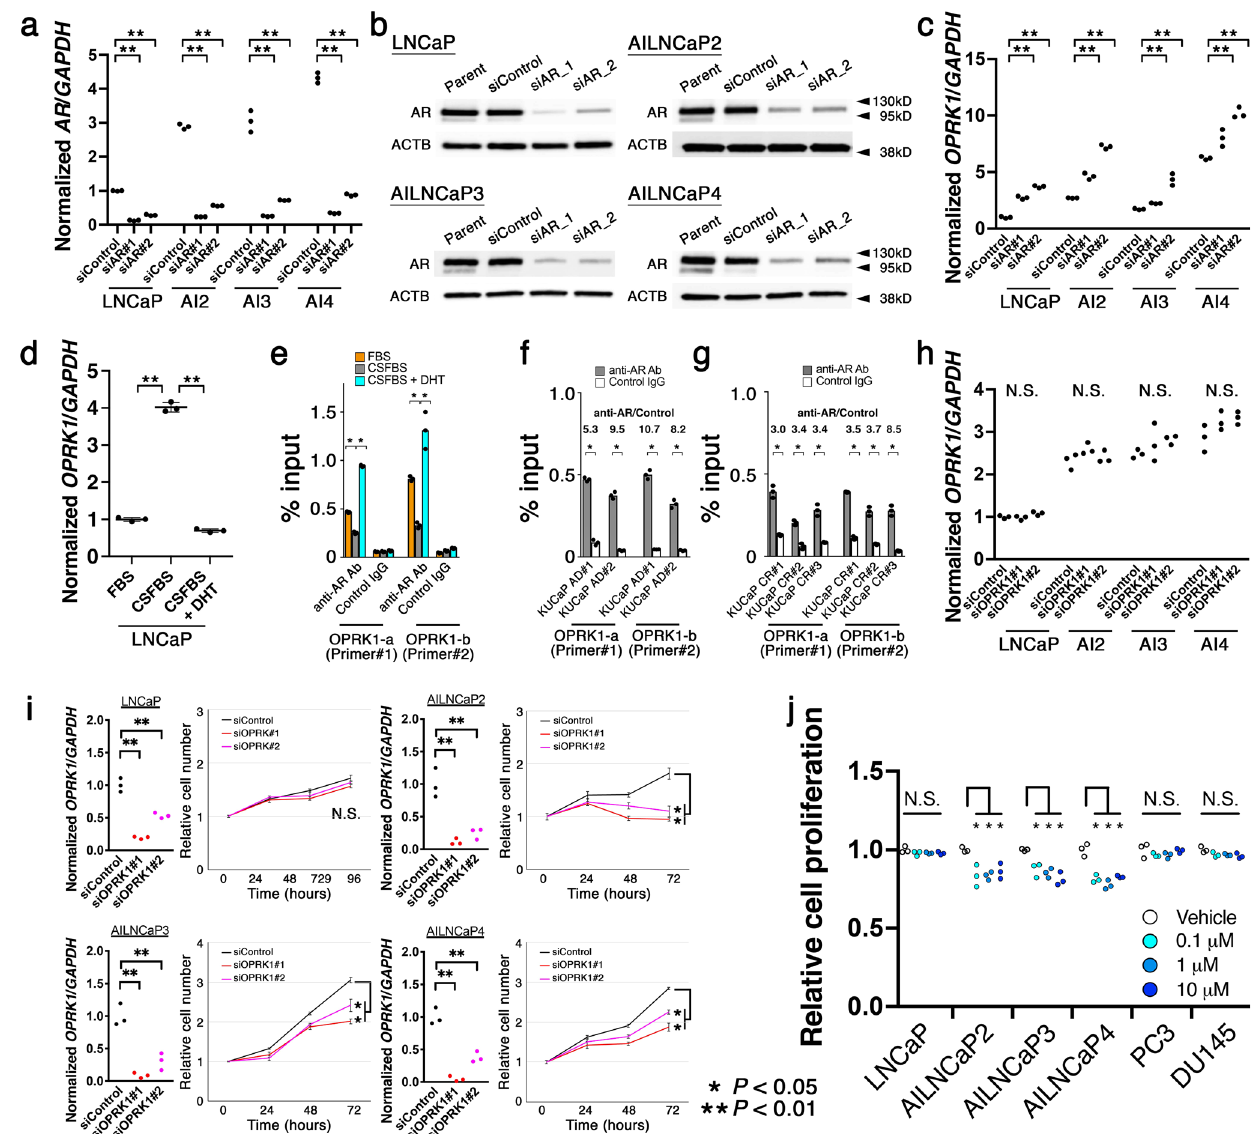
Fig. 4 AR suppression upregulates OPRK1, which underpin androgen-independent growth of androgen-independent derivatives of LNCaP cells. a , b Expressions of AR in LNCaP, AILNCaP2 (AI2), AILNCaP3 (AI3), and AILNCaP4 (AI4) treated with siRNA for GFP (siControl) and AR (siAR#1 and siAR#2) assessed by quantitative RT-PCR ( a ) and western blot ( b ). ** P < 0.01, Normalized by GAPDH ( a ) and β -actin (ACTB, b ). c Expression of OPRK1 in LNCaP, AILNCaP2 (AI2), AILNCaP3 (AI3), and AILNCaP4 (AI4) treated with siRNA for GFP (siControl) and AR (siAR#1 and siAR#2) assessed by quantitative RT-PCR. ** P < 0.01, Normalized by GAPDH . d Expression of AR (left) and OPRK1 (right) in LNCaP cultured in media supplemented with 10% FBS, charcoal-stripped FBS (CSFBS), and CSFBS plus 1 nM dihydrotestosterone. ** P < 0.01, Normalized by GAPDH . e Chromatin immunoprecipitation (ChIP) using anti-AR antibody and control IgG followed by quantitative RT-PCR using two primers for OPRK1 promoter (OPRK1-a, and -b) in LNCaP cells cultured as in d . ** P < 0.01. f , g ChIP using anti-AR antibody and control IgG followed by quantitative RT-PCR using two primers for OPRK1 promoter (OPRK1-a, and -b) in KUCaP2 AD ( f ) and CR ( g ) tumors. ** P < 0.01. h Expression of AR in LNCaP, AILNCa P 2 (AI2), AILNCaP3 (AI3), and AILNCaP4 (AI4) treated with siRNA for GFP (siControl) and OPRK1 (siOPRK1#1 and siOPRK1#2) assessed by quantitative RT-PCR. Normalized by GAPDH . i Expression of ORPK1 normalized by GAPDH (left) and cell proliferation (right) in LNCaP, AILNCaP2 (AI2), AILNCaP3 (AI3), and AILNCaP4 (AI4) treated with siRNA for GFP (siControl) and OPRK1 (siOPRK1#1 and siOPRK1#2). * P < 0.05, ** P < 0.01. j Summarized cell proliferation rates of indicated cells with regard to the concentration of supplemented nor-BNI, OPRK1 inhibitor. * P <